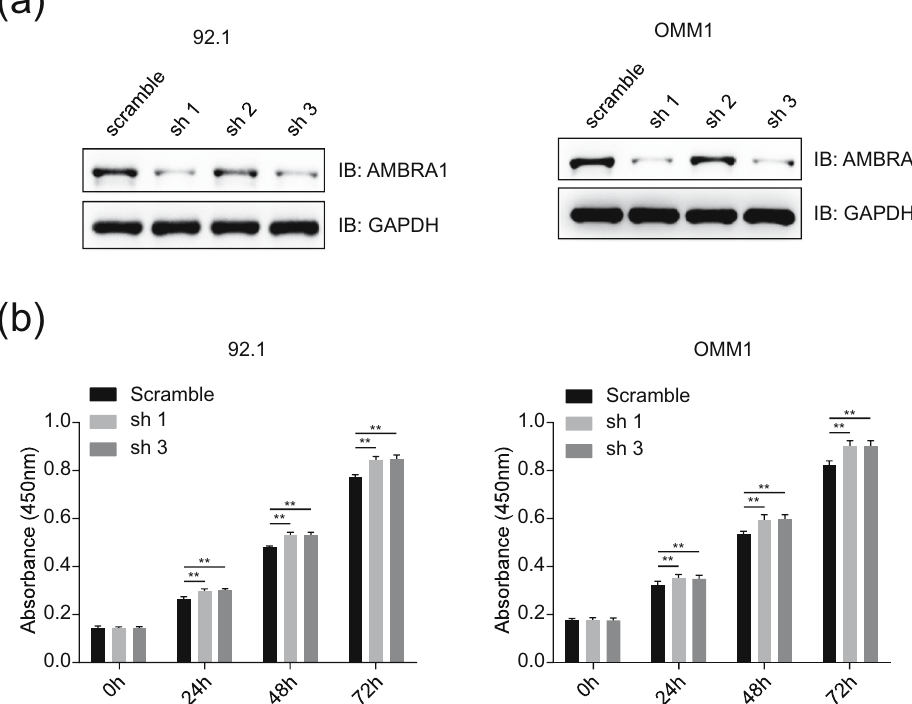
Figure 2: The ablation of AMBRA1 promotes the proliferation of UVM cells. ( a ) Test of the knockdown e ffi ciency of shRNAs targeting AMBRA1 by immunoblotting analysis. The shRNAs for AMBRA1 were transfected into 92.1 and OMM1 cells, and then puromycin ( 5 µg/mL ) selection was used to establish stably expressing cell lines before subjecting to immunoblotting analysis. ( b ) AMBRA1 knockdown promotes the proliferation of UVM cells. OMM1 and 92.1 cells stably expressing AMBRA1 shRNAs ( sh 1 and sh 3 ) were seeded into 96 - well plates, and the cell viability was detected using the CCK - 8 assay at the indicated time points. The data were expressed as mean ± SD and analyzed using a one - way ANOVA with Tukey ’ s post hoc test. ** P < 0.01, very signi fi cantly di ff erent, three independent